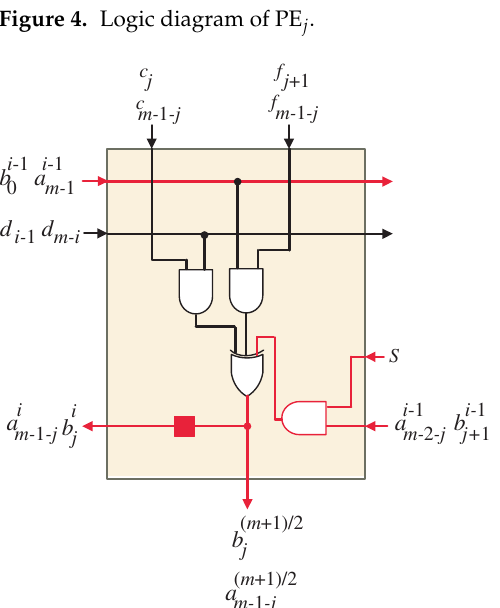
Figure 5. Simplified Logic diagram of PE j